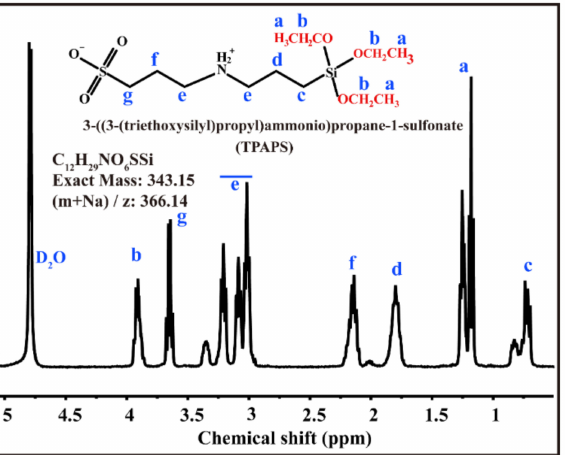
Figure 1. The molecular structure of the designed hybrid precursor (TPAPS) and its corresponding 1 H NMR spectrum; D 2 O was used as the solvent for the NMR characterization, and tetramethylsilane was used as an internal